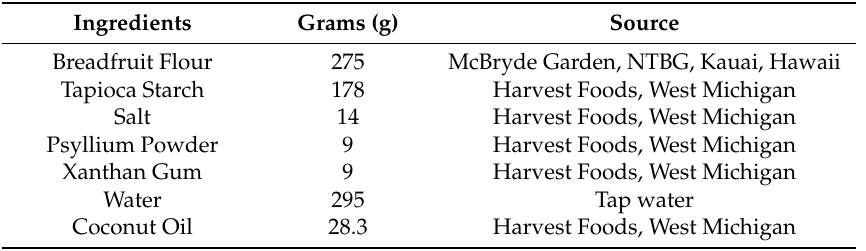
Table 1. Breadfruit pasta product